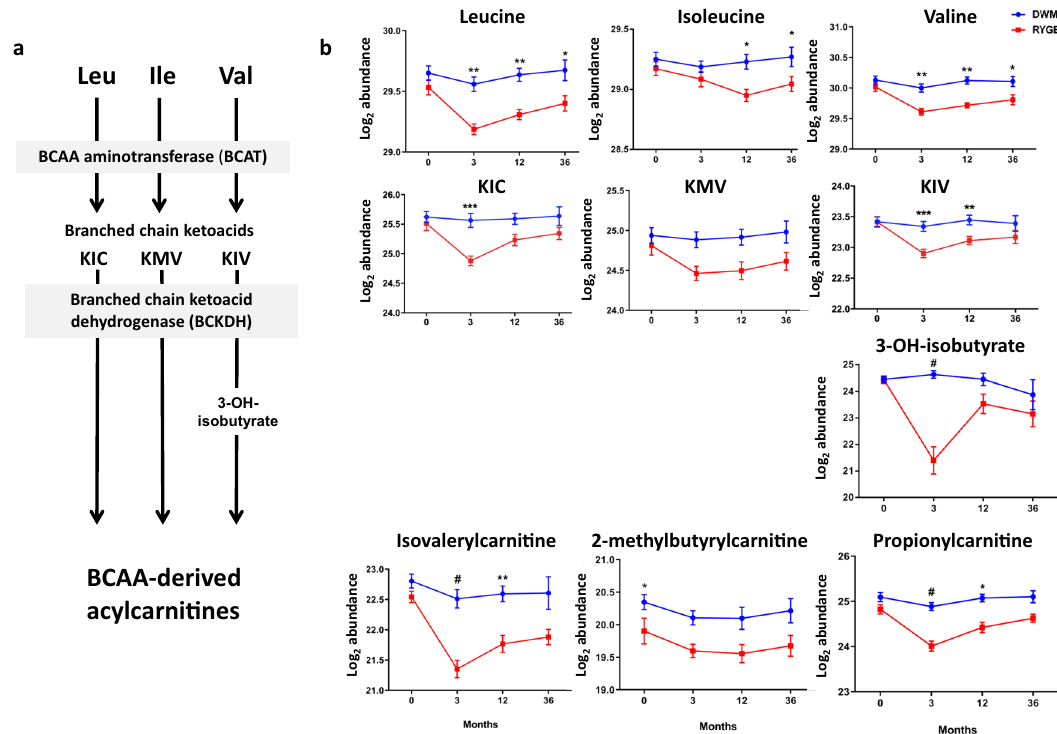
Fig. 4 Branched chain amino acids (BCAA) and downstream metabolites. a Schematic of BCAA metabolic pathway showing measured analytes. KIC, KMV, and KIV indicate the branched chain ketoacids ketoisocaproate, ketomethylvalerate, and ketoisovalerate, respectively. b Relative abundance of measured analytes, aligned to position in pathway in ( a ). Data were analyzed by two-sided moderated t-tests; post-baseline time points were analyzed using change from baseline. Data are reported as mean ± SEM on the log2 scale. Analysis was derived from samples from independent human participants. RYGB at 0, 3, 12, and 36 months: n = 19, 18, 19, and 13; DWM: n = 19, 18, 16, 9. Nominal p -values are as follows: Leucine: 3 mo ** = 0.001, 12 mo ** = 0.0041, 36 mo * = 0.03; Isoleucine: 12 mo * = 0.017, 36 mo * = 0.036; Valine: 3 mo ** = 0.0019, 12 mo ** = 0.0013, 36 mo * = 0.016; KIC: 3 mo *** = 0.00016; KIV: 3 mo: *** = 0.00026, 12 mo: ** = 0.0045. 3-OH-isobutyrate: 3 mo: #<0.0001; isovalerylcarnitine: 3 mo: #<0.0001, 12 mo: ** = 0.002; 2- methylbutyrylcarnitine: 0 mo: * = 0.025; propionylcarnitine: 3 mo: #<0.0001, 12 mo: * = 0.016. isobutyrylcarnitine: 0 mo: * = 0.024. Source data and FDRs are available in Supplementary Data